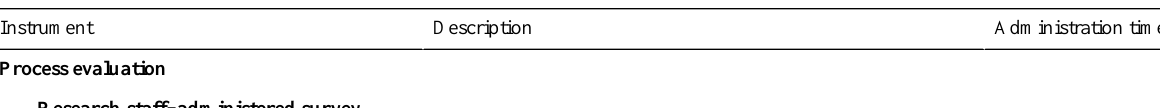
Table 1. Study instruments, surveys, and active